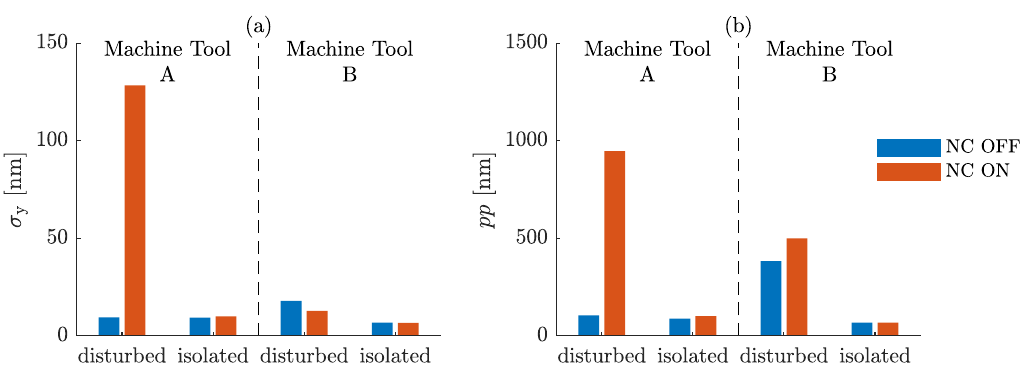
Figure 14. Evaluated parameters, standard deviation σ y ( a ) and peak-to-peak value pp ( b ), of output signal y ( t ) in testing device Configurations D2 (target coupled to spindle/“disturbed”) and D3 (decoupled spindle measurement setup/“isolated”) in different machine tool environments and under different operating